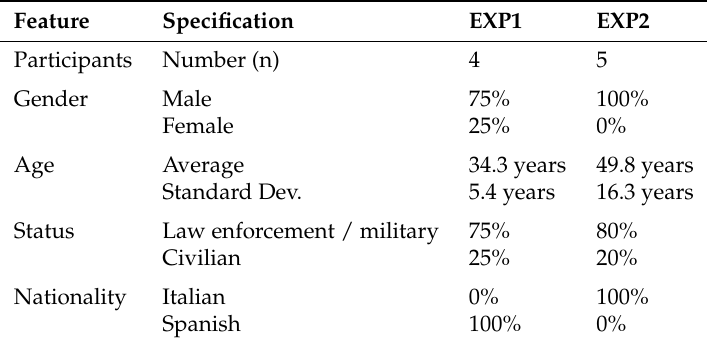
Figure 7. MARISA Game session with the Italian Navy. Table 4. Participants demographics and